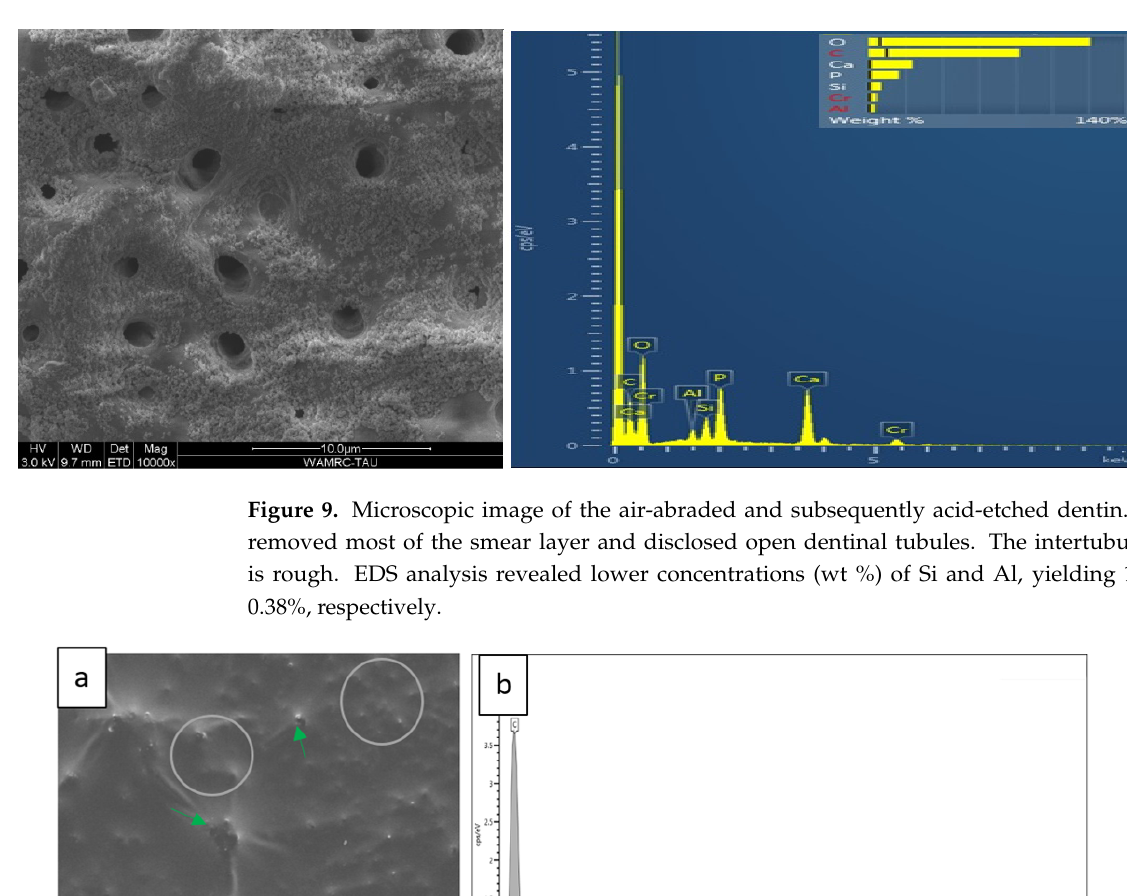
(green arrows). White circles denoted the area of the EDS analysis, which revealed the following elements (wt %): C 63.13%, O 30.72%, Ca 2.2%, P 0.48%, Si 2.05%, Al 0.88% ( b ).